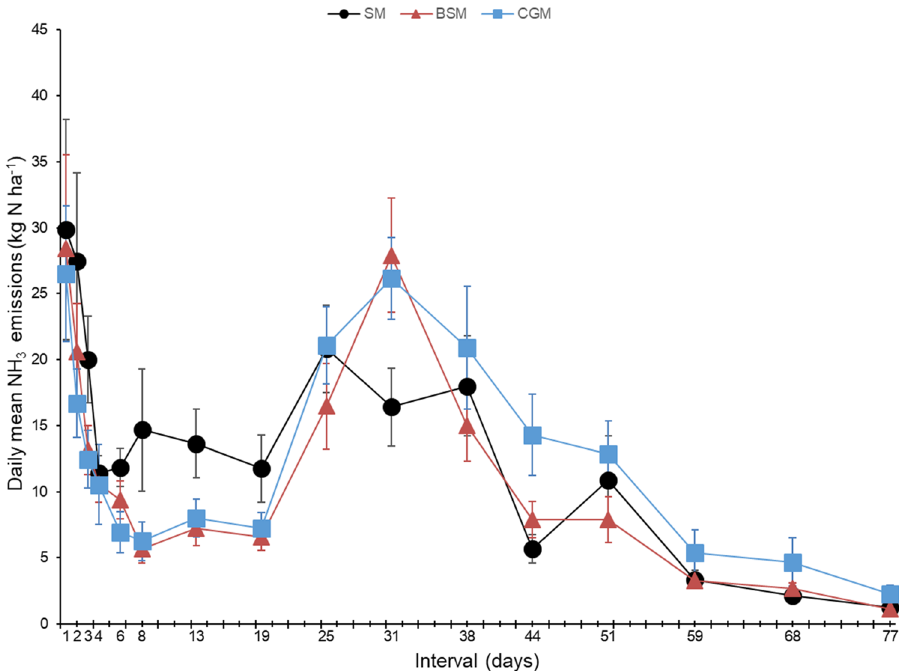
Figure 5. Daily mean NH 3 emission from the manure of Nellore cattle fed with sources of rumen undegradable protein during the finishing phase in feedlot. Evaluations started after the animals were removed from the feedlot. SM = manure of animals fed soybean meal as a source of rumen degradable protein (RDP), BSM = manure of animals fed by-pass soybean meal as a source of rumen undegradable protein (RUP), CGM = manure of animals fed corn gluten meal as a source of RUP. Chamber considered as an experimental unit (n = 9). The error bars representing standard error of the mean.